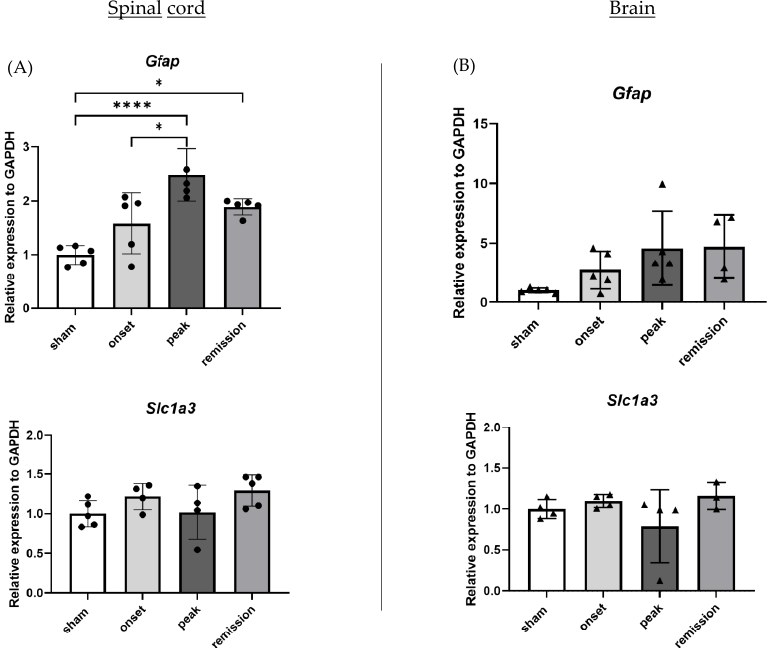
Figure 3. Differential expression of genes representative of astrogliosis in CNS organs during the different phases of PLP-induced EAE. The levels of mRNA transcripts for the selected genes relative to Gapdh were measured in the spinal cord ( A ) and brain ( B ) samples isolated from adjuvant controls and EAE mice on the onset, peak, and remission phases by RT-qPCR. A number of 3 to 5 mice was used in the experiment. Each symbol represents a sample. * p < 0.05, **** p < 0.0001, one-way ANOVA. 2.1.4. Oligodendrocyte and Neuronal Damage-Related Genes Although the RNA levels of Cnp do not differ significantly between the groups, the attacks on mature oligodendrocytes are reflected by the decrease in Mog RNA levels in the spinal cord samples at the peak of the disease coinciding with the maximal degree of disability (Figure 4). Neuronal damages are reflected by the important decrease in neuro- filament ( Nfh and Nfl ) and Mapt RNA levels during the onset and peak of the disease that still persist during remission (Figure 5).